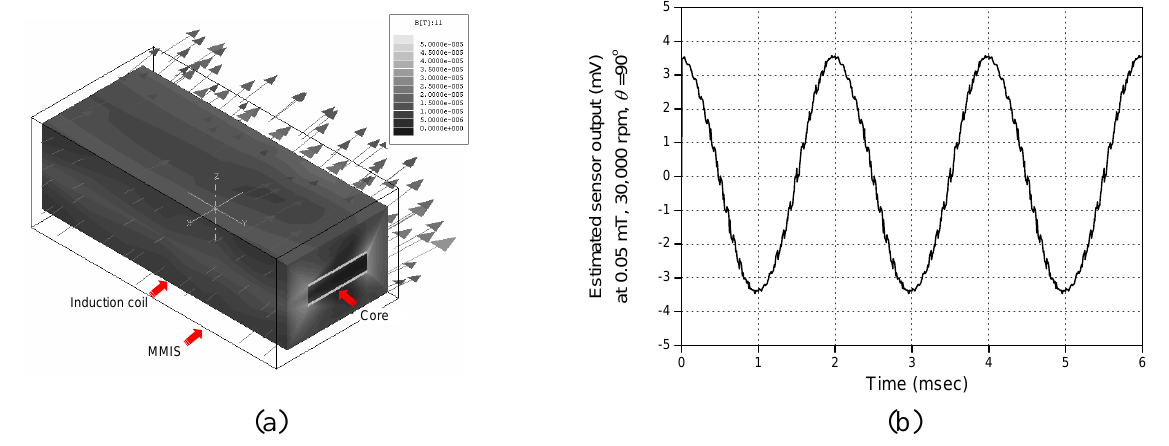
Figure 7. Simulation results of MMIS at magnetic flux density of 0.05 mT, rotational velocity of 30,000 rpm and angle between magnetic field and ammunition rotation axis of 90°: (a) Estimated magnetic flux density distribution; (b) Estimated induction voltage of MMIS as function of time.